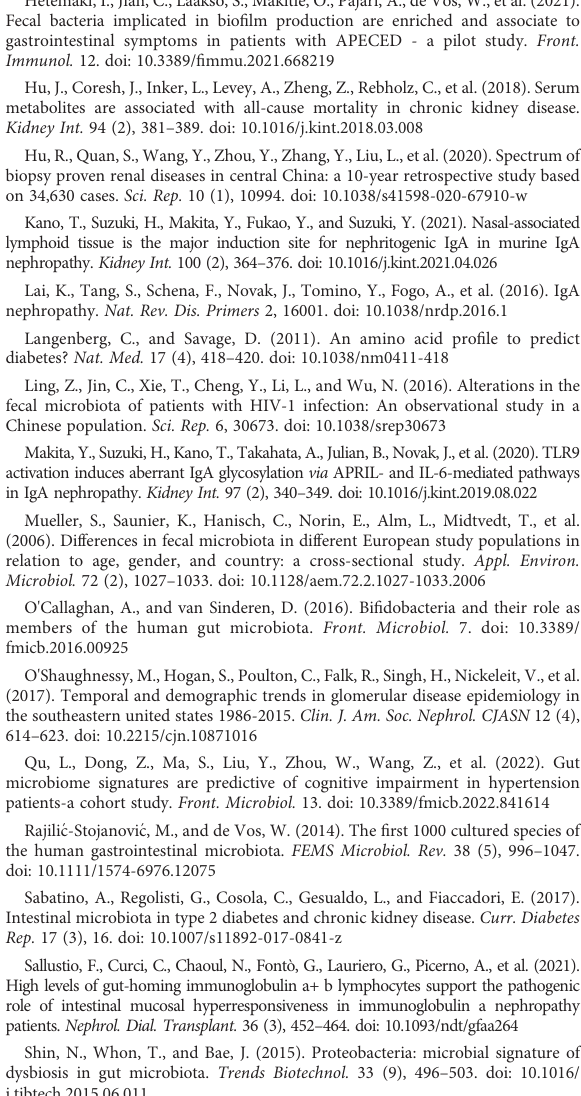
SUPPLEMENTARY FIGURE 4 Phylogenetic pro fi les of gut microbes. (A) : Shannon index were increased in IgAN. (B) : PCA based on the distribution of intestinal microbe OTUs of IgAN and n_IgAN. (C) : Comparison of microbial composition on phylum level. (D) : Comparison of differential microorganisms on phylum level. Log 10 abundance of differential microorganisms on genus level (* P <0.05; ** P <0.01; *** P <0.001). (E) : According to the LDA value distribution histogram, 24 genera were signi fi cantly enriched in n_IgAN, while 21